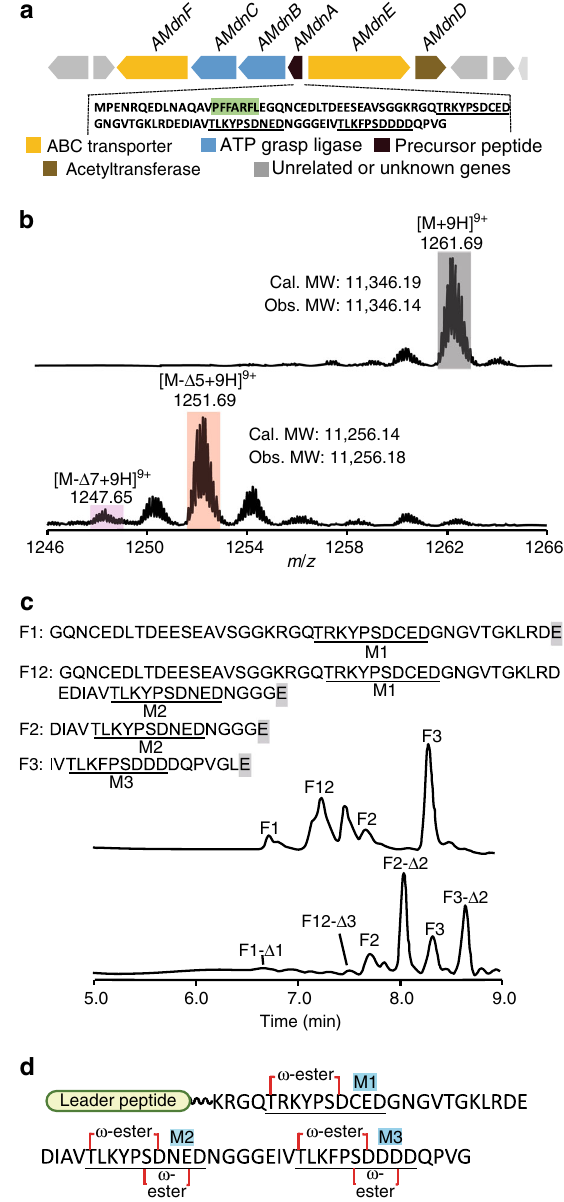
Fig. 2 AMdnC macrolactonizes the three core peptides within AMdnA. a A putative microviridin gene cluster was identi fi ed from Anabaena sp. PCC7120. The conserved binding motif of the leader peptide within AMdnA is shaded in green while three predicted core peptides are underlined with solid lines. b HR-MS analysis detected an array of species with one to seven dehydrations ( Δ ) after incubating AMdnA with AMdnC at a molar ratio of 45:1 for 16 h. The most abundant species lost fi ve waters from AMdnA. c HPLC traces of intact (up) and processed (down) AMdnAs after GluC digestion. Key chromatographic peaks were labeled with the names of corresponding peptide fragments released by GluC. d The deduced structure of the most abundant species in the AMdnC reaction. Key acidic residues involved in the lactonizations of core peptides were